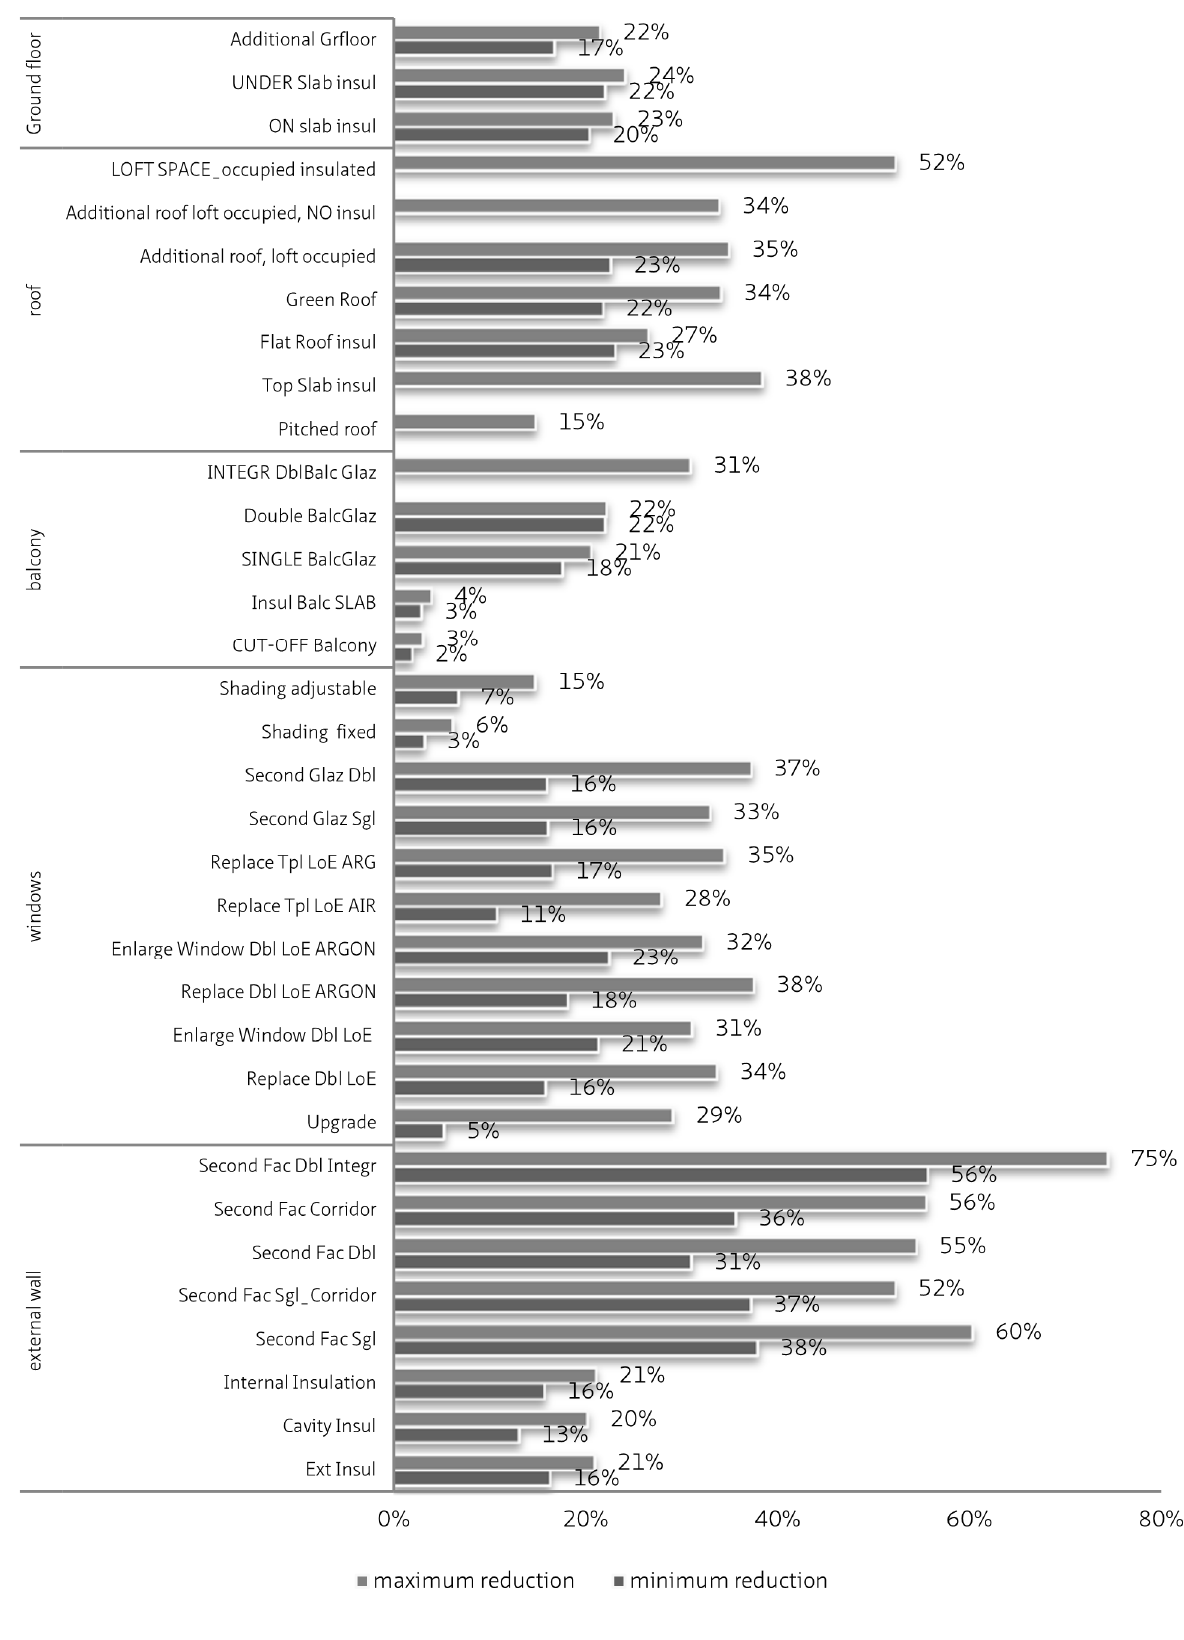
Figure 1. Overview of heating demand reduction after the application of retrofitting measures in the respective components. The values refer to typical apartment and they are average for different WWRs and